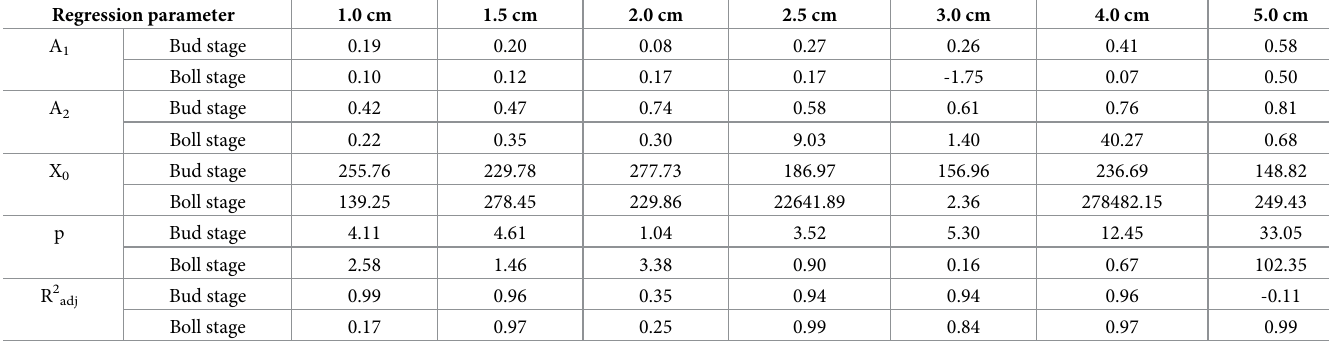
Table 5. Regression parameters of logistic equations between the defoliation rate and hail fall density. Regression